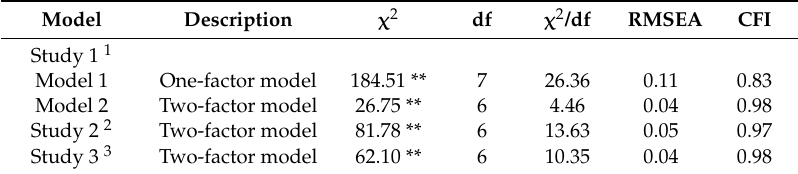
Table 5. Results of Confirmatory Factor Analysis (Six Items), AMOS Model Fit